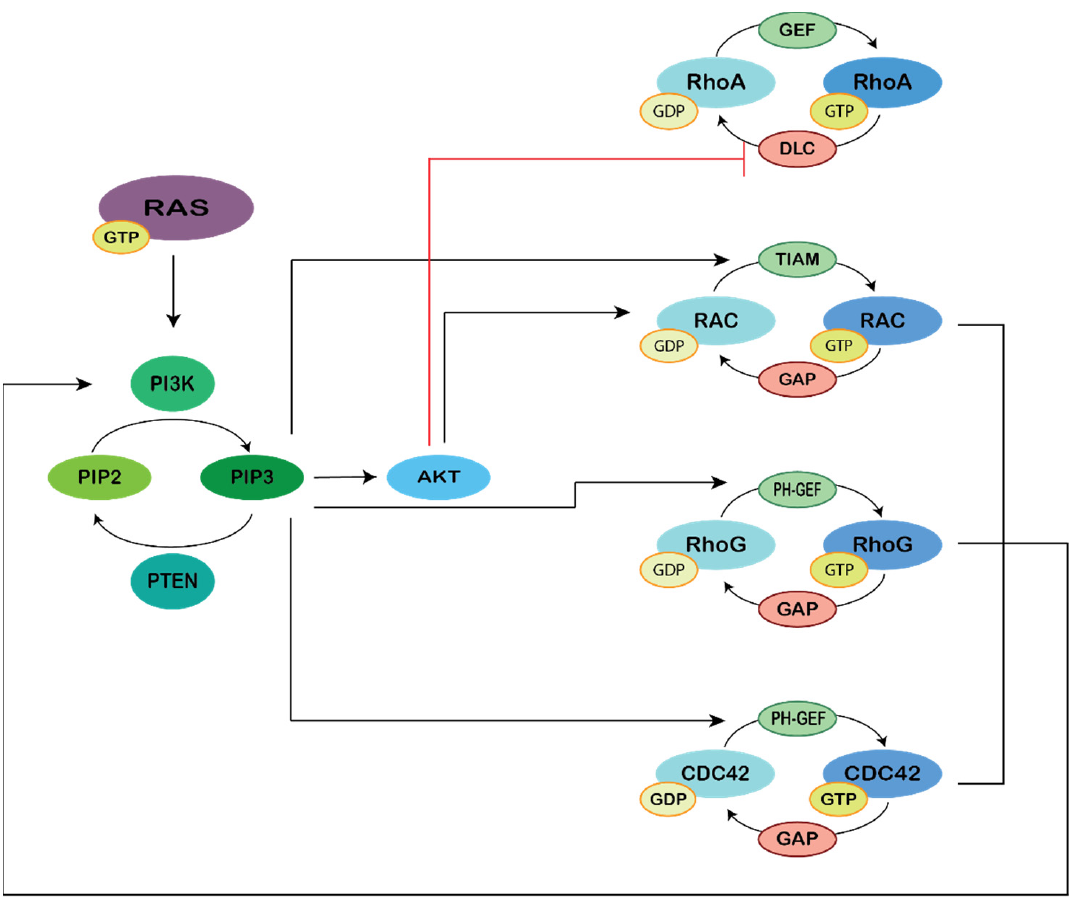
Figure 2. PI3K regulation of Rho-dependent signaling. Figure representing the complexity of Ras regulation of Rho by PI3K. Ras-GTP activates PI3K/AKT that, in turn, activates Rac to regulate actin polymerization and membrane ruffling. Active AKT inhibits DLC1 (a GAP for RhoA), increasing levels of RhoA, facilitating formation of focal adhesions. Formation of PtdIns(3,4,5)P3 (PIP3) recruits PH-containing Rho GEFs, including Tiam1, to the plasma membrane promoting activation of several Rho-GTPase members. PTEN and SHIP (not represented) dephosphorylates PIP3, thus antagonizing RAC activation by PIP3. Furthermore, combined activation of Rac, Cdc42 and RhoG potentiates activation of PI3K, creating a positive feedback on PI3K